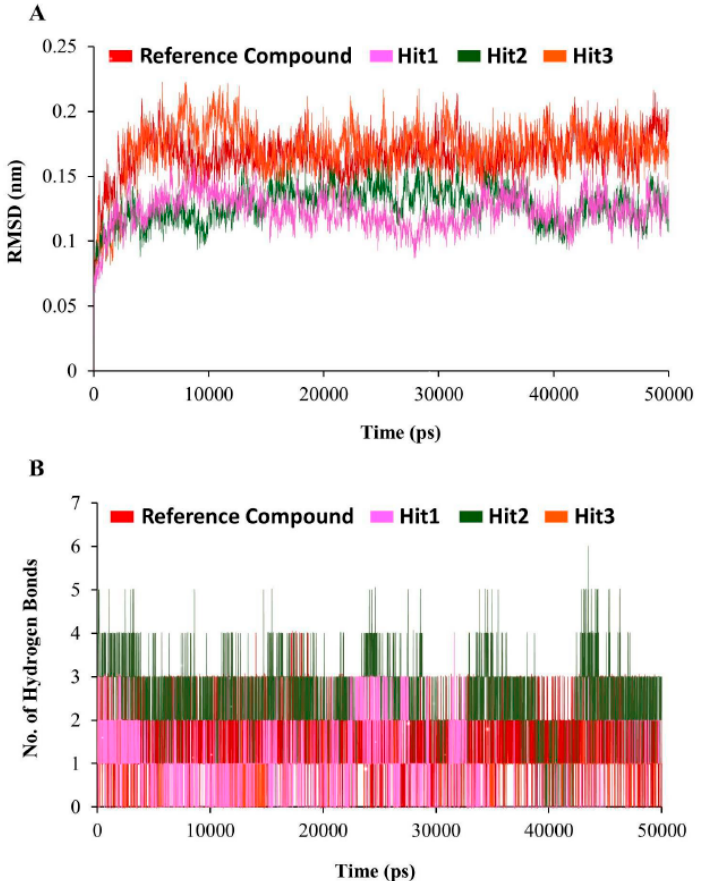
Figure 7. Molecular dynamics simulation analyses. ( A ) The root mean square deviation (RMSD) profile of the backbone atoms of human dihydrofolate reductase (hDHFR). Each system suggested the stable RMSD during the entire simulation run. Color scheme is depicted as hDHFR in complex with reference compound (red), Hit1 (magenta), Hit2 (green), and Hit3 (orange). ( B ) The number of intermolecular hydrogen bonds between protein and compound during the 50 ns MD simulations. The reference compound, Hit1, Hit2, and Hit3 are displayed as red, magenta, green, and orange. J. Clin. Med. 2019 , 8 , 233